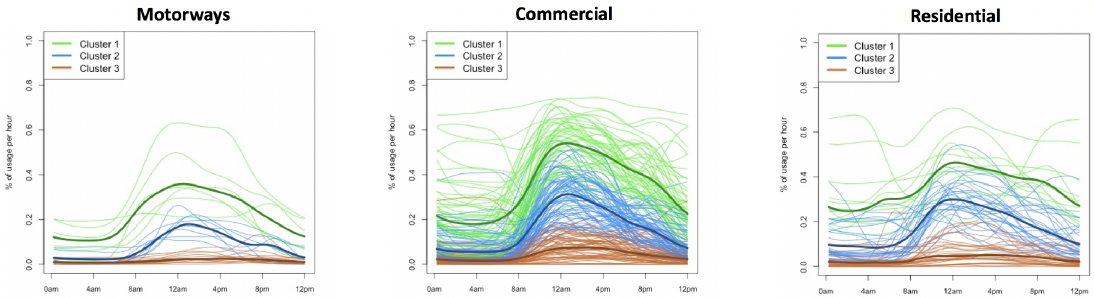
Figure 16. Clustering results for Standard-Commercial, Standard-Motorway and Standard-Residential subgroups